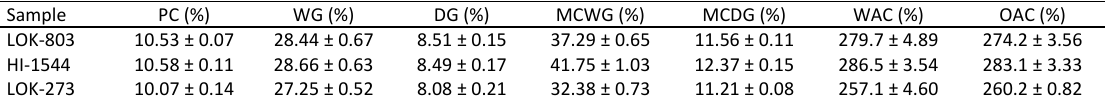
Fig. 2: Soybean varieties collected from the local farms in Rewa district, Madhya Pradesh, India. (a) Ahilya-3 (NRC-7). (b) Ahilya-2 (NRC-12). (c) Ahilya-1 (NRC-2). (d) Shakti (MAUS-81). (e) Pratap soya (RKS-18) Table 1: Values of protein and gluten composition and gluten characteristics of wheat cultivars Sample